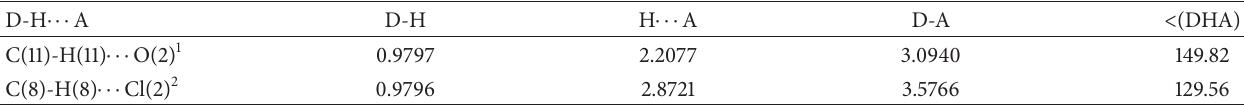
Table 4: Hydrogen-bond distance (˚A, ∘ ) of the title